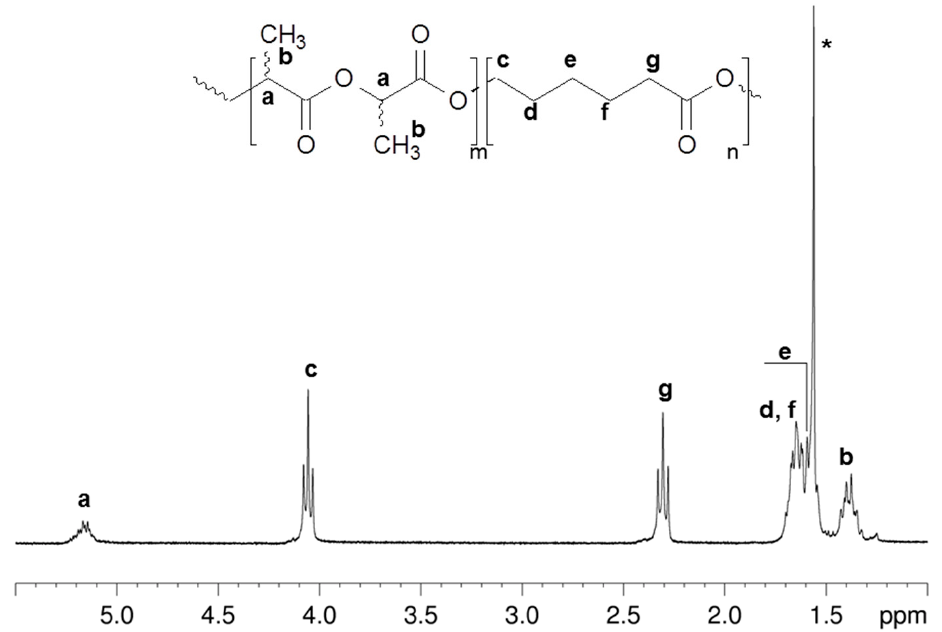
Figure 1. 1 H NMR spectrum of poly-(D,L-Lactide- block - ε -caprolactone) (CDCl3, 25 °C, 400 MHz). * Residual water in deuterated solvent.